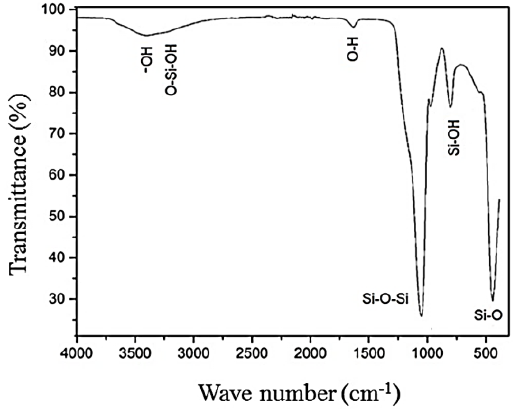
Figure 6. Infrared absorption spectrum of the bimodal silica.